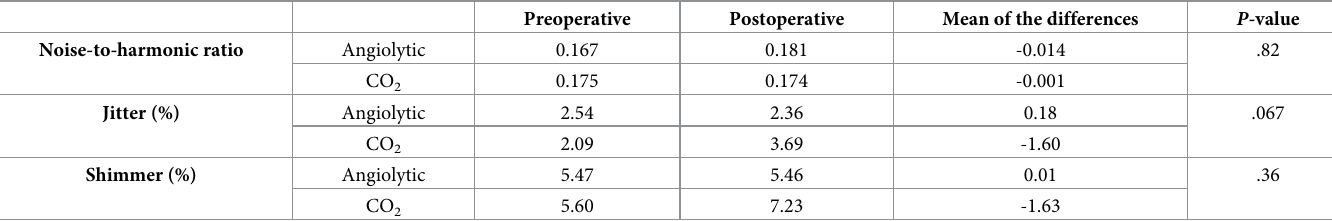
Table 4. Acoustic parameters measured by Multi-dimensional Voice Program before and after the